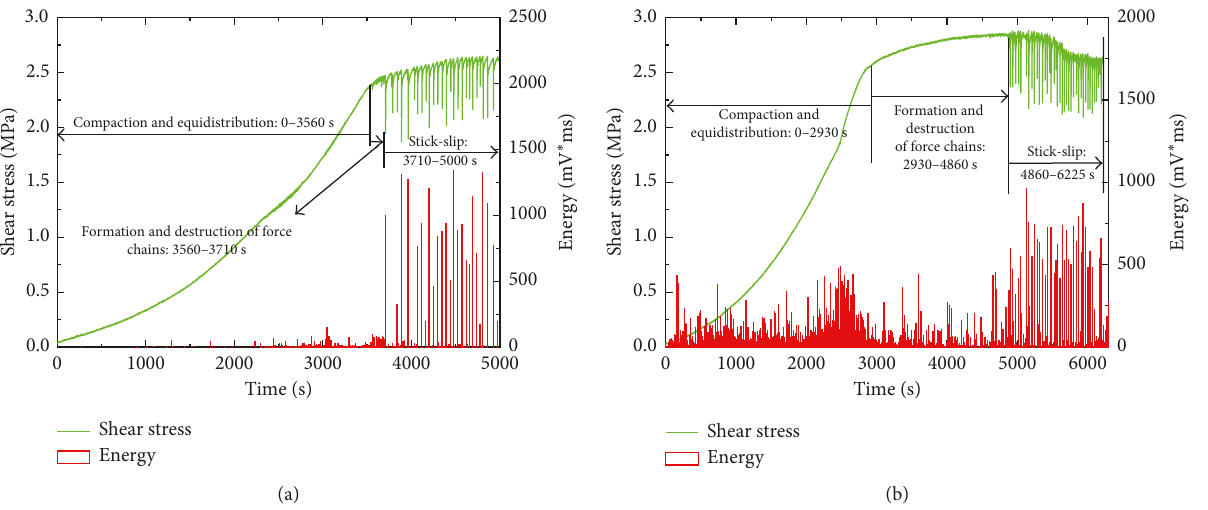
Figure 4: Variations of shear stress and AE energy of (a) Sample 2 and (b) Sample 3.